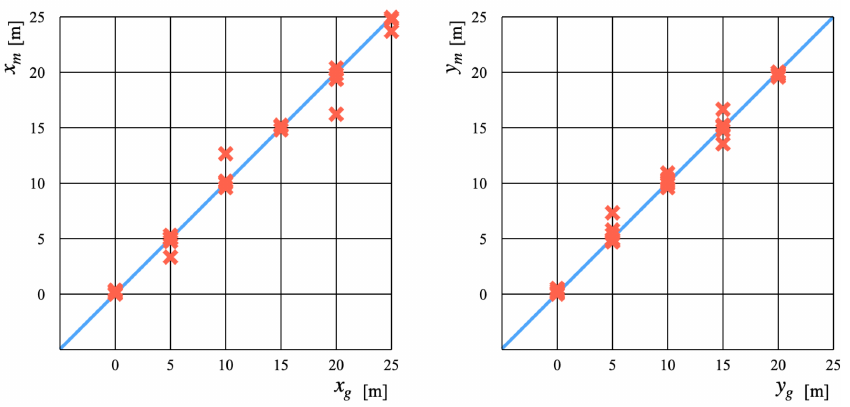
Figure 18. Scatter plots showing the GT coordinates and estimated coordinates for Experiment